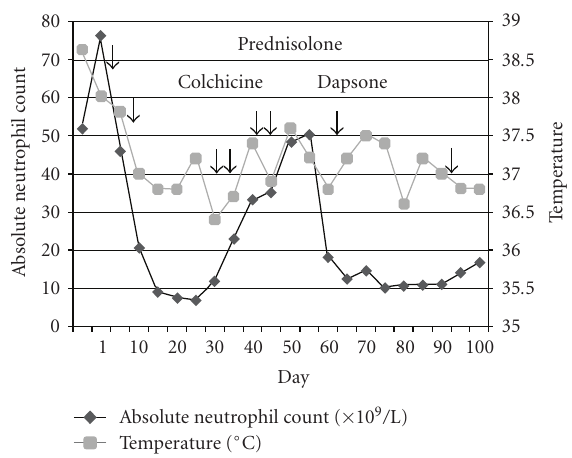
Figure 2: The e ff ect of various pharmacotherapies on the absolute neutrophil count and temperature (each arrow represents a 21- gram-dose of